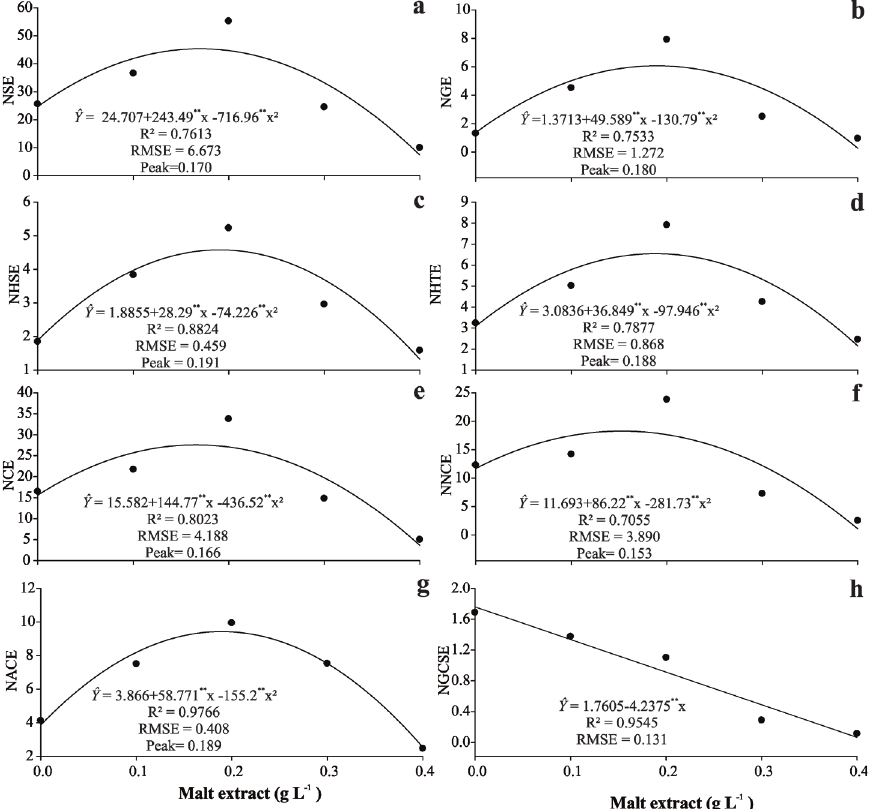
Figure 2 - Number of somatic embryos ( a ), number of globular embryos ( b ), number of heart- shaped embryos ( c ), number of torpedo-shaped embryos ( d ) number of cotyledonary embryos ( e ), number of normal cotyledonary embryos ( f ), Number of abnormal cotyledonary embryos ( g ), and number of germinated cotyledonary somatic embryos ( h ) per callus of C . papaya L. ‘Golden THB’ on maturation medium with different concentrations of malt extract 0.1; 0.2; 0.3; 0.4 g L -1 after 45 days of culture. **Significant at p ≤ 0.01 probability level by the F